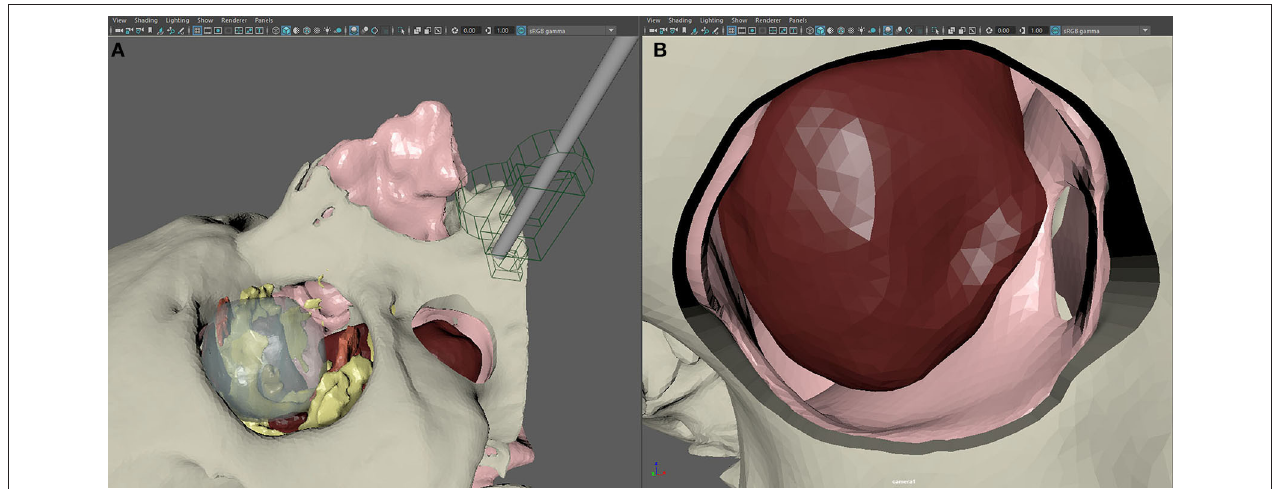
FIGURE 4 | Setup of the scene in Autodesk Maya for the creation of virtual endoscopy. (A) The endoscope is recreated in its real size using a geometrical replica and a virtual camera. (B) Simulated endoscopic view of the transmaxillary portal, the paranasal sinuses, and the tumor.